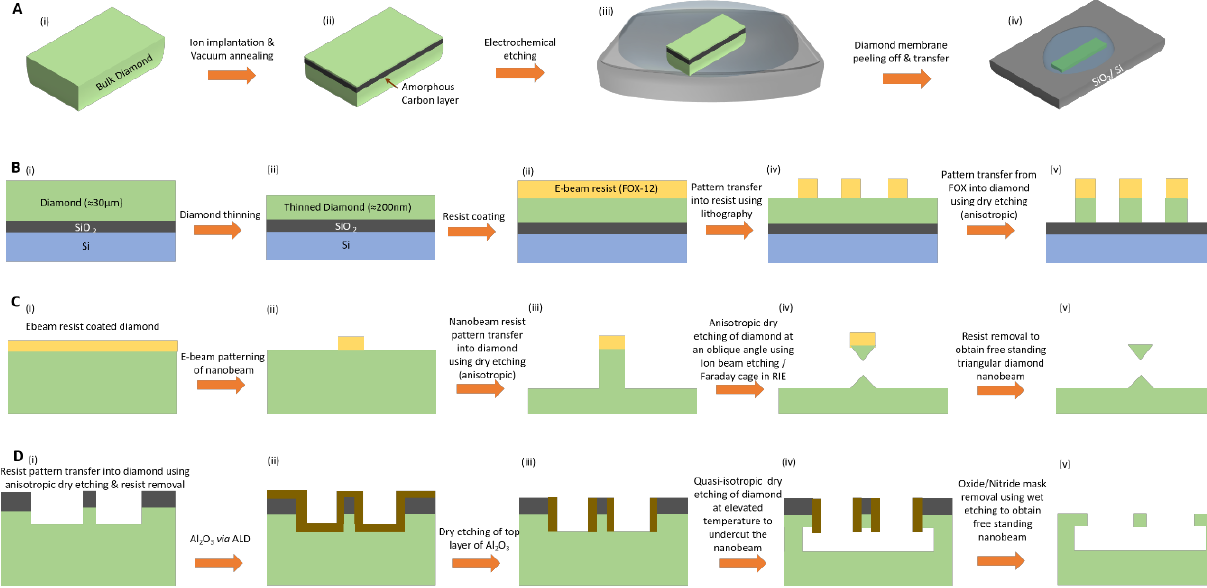
Figure 1. Schematics of different methods realized for diamond nanofabrication: ( A ) Lift-off method in which ions are implanted into bulk diamond to create an amorphous carbon layer (ii) few microns below the surface, followed by electrochemical etching of the damaged layer (iii) and transfer of the peeled-off diamond membrane over another substrate. Figures adapted from Ref. [27] originally published by The Royal Society of Chemistry under creative commons license CC BY 3.0; ( B ) Thin-down technique, where bulk diamond is transferred over another substrate (e.g., SiO 2 /Si) and dry etched to obtain thin diamond membranes of ≈ 200 nm (i,ii). The structures in nanomembrane are created by patterning of the spin coated resist using E-beam lithography (iii, iv), and subsequent transfer into diamond using dry etching process (v). Figures adapted from Ref. [28] copyright IOP publishing, Reproduced with permission. All rights reserved; ( C ) Angled etching method in which lithographically defined nanobeam resist pattern (i,ii) is transferred over the underlying diamond substrate using anisotropic dry etching process (iii), followed by dry etching at an oblique angle using ion beam etching or Faraday cage in RIE (iv) to release the diamond nano-structures and subsequent resist mask removal to obtain free-standing, triangular nanobeam (v). Figures reprinted (adapted) with permission from [33,39] Copyright (2019) by the American Physical Society for Ref. [33], for Ref. [39] reprinted under creative commons license CC BY 4.0; ( D ) Isotropic undercut etching method, where a combination of anisotropic and isotropic dry etching processes is used to obtain free-standing diamond nano-structures. Nanobeam pattern transfer using hard mask into diamond via a combination of e-beam lithography and anisotropic etching (i). The patterned diamond substrate is coated conformally with Al 2 O 3 via ALD technique (ii) and dry etched (iii) to remove the top layer of Al 2 O 3 . Subsequently quasi-isotropic oxygen etching is carried out to undercut the nanobeam structure (iv) and wet etching of hard mask to obtain free-standing nanobeam structure over bulk diamond (v). Figures reprinted (adapted) from [34,36], for Ref. [34] with the permission of AIP Publishing; for Ref